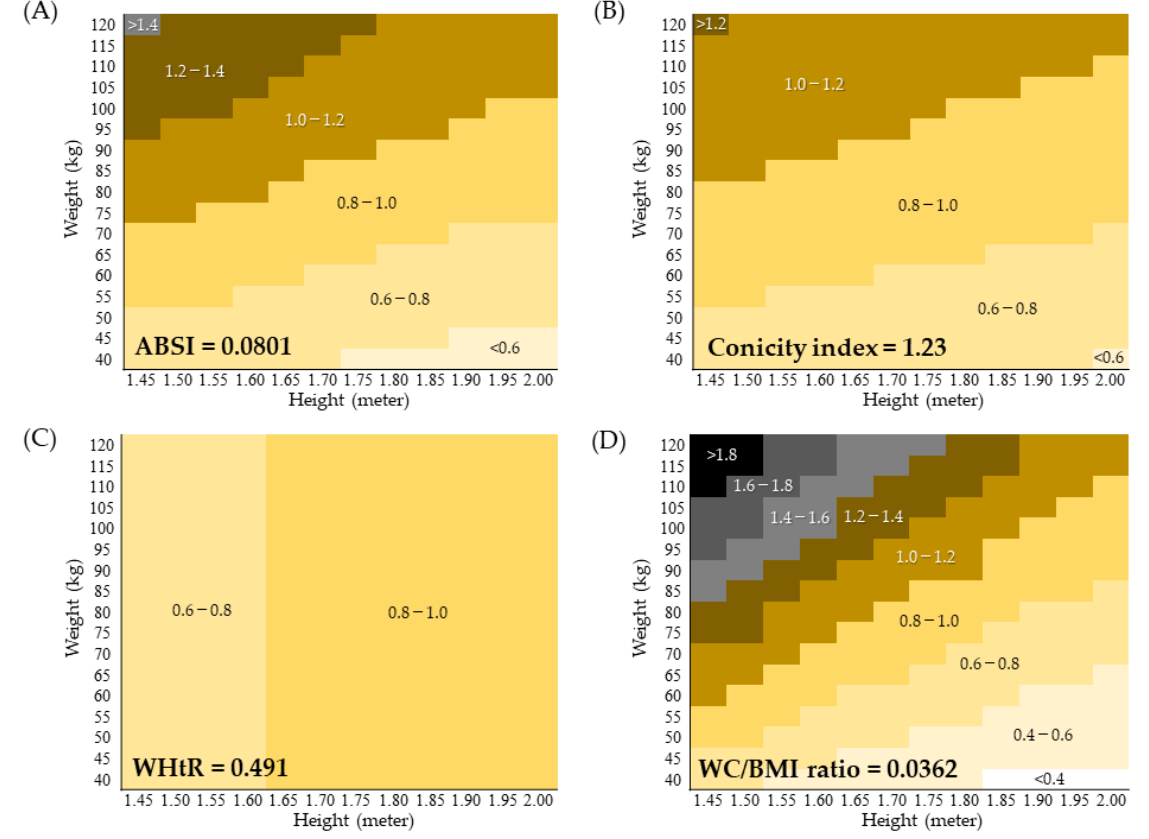
Figure 1. Waist circumference (m) matrix constructed from weight, height, and the cutoff of each abdominal obesity index. In a matrix, each cell that intersects a column (height) and a row (weight) is the WC calculated from that height and weight at the cutoff value. The waist circumferences are categorized by color into various levels. Cutoff values of ( A ) ABSI, ( B ) conicity index, ( C ) WHtR, and ( D ) WC/BMI ratio are shown in the matrices. ABSI, a body shape index; WHtR, waist-to-height ratio, WC, weight circumference; BMI, body mass index.